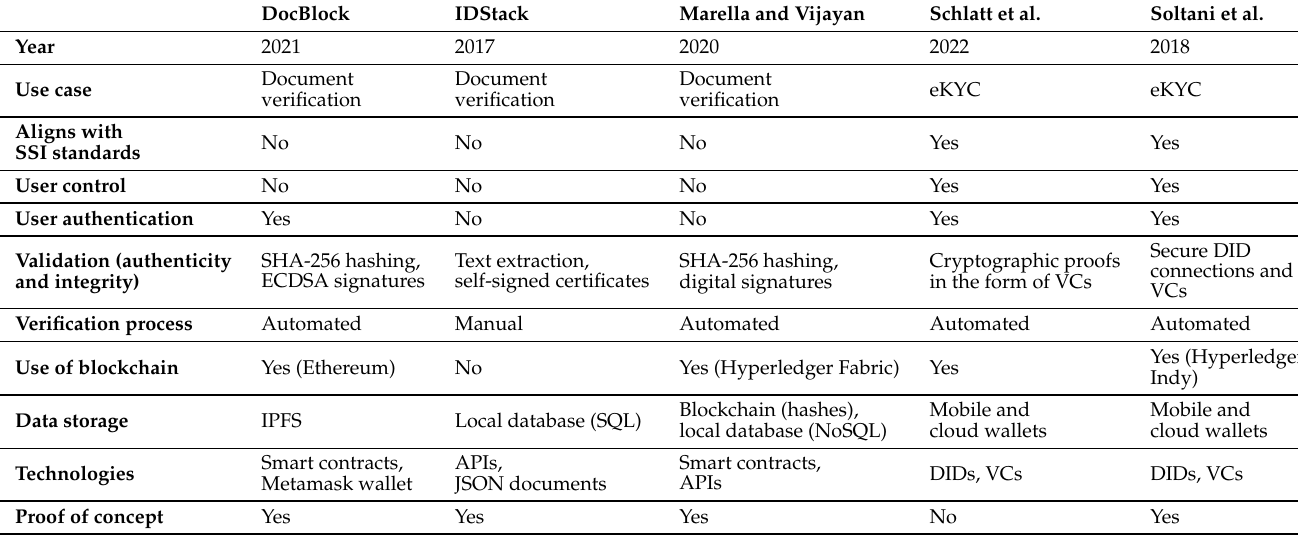
Table 1. Comparison of solutions for document